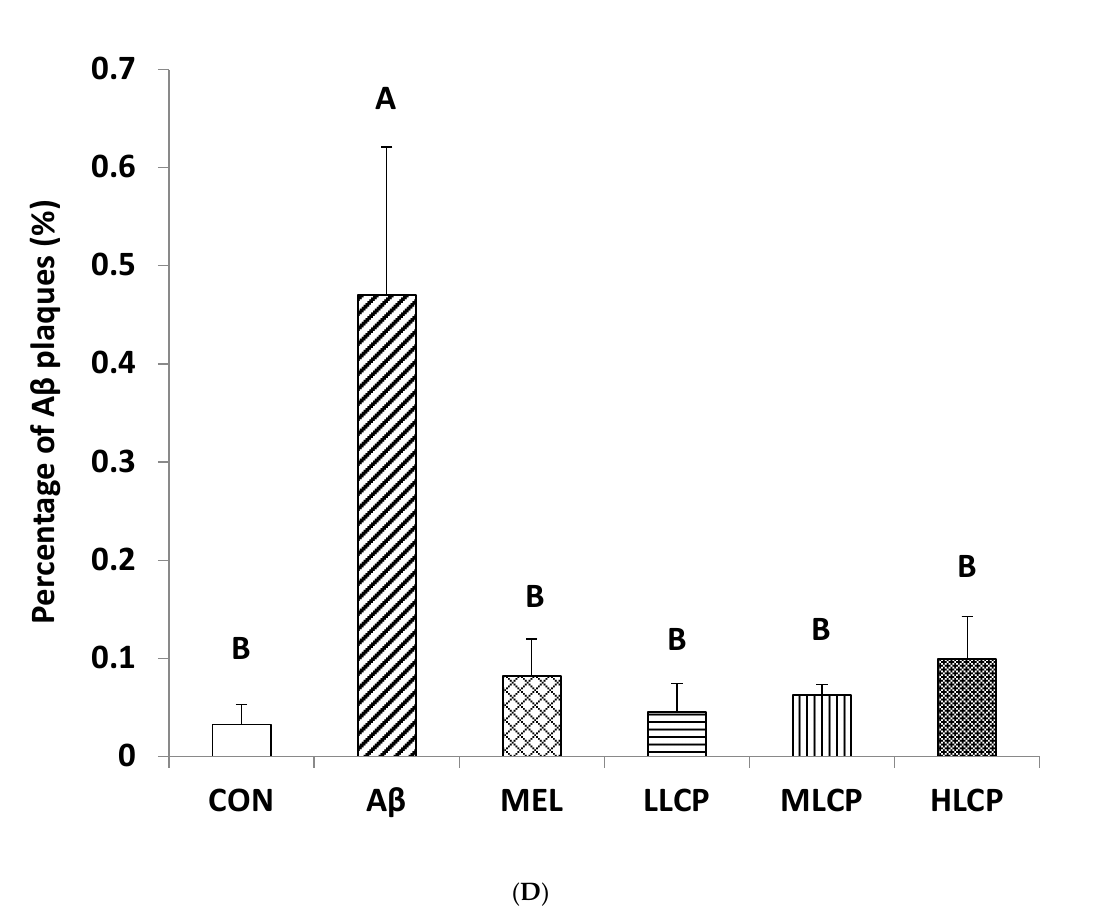
Figure 4. Effects of LCP fruit powder on oxidation stress and Alzheimer’s disease pathogenic factors using enzyme-linked the immunosorbent assay method in A β -induced Alzheimer’s mice brains. ( A ) The concentration of malondialdehyde (MDA). ( B ) The concentration of protein carbonyl. ( C ) The concentration of phosphorylated τ -protein. ( D ) The percentage of A β plaques. Values are expressed as mean ± SD ( n = 8). Means with different letters (A and B) are significant differences between the groups ( p < 0.05). Abbreviations: symbols are represented in Table 2.